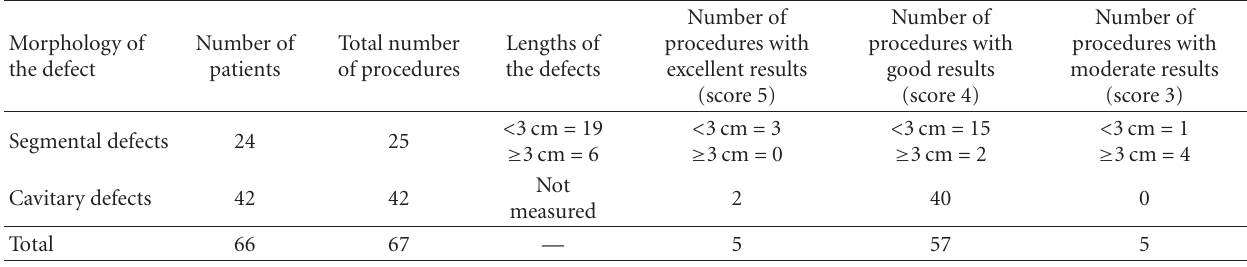
Table 3: Final results according to the morphology of the bone defects. According to the morphology, most of the defects were classified as cavitary bone loss and presented good results. Moderate results were observed mainly in segmental defects equal or bigger than 3cm in